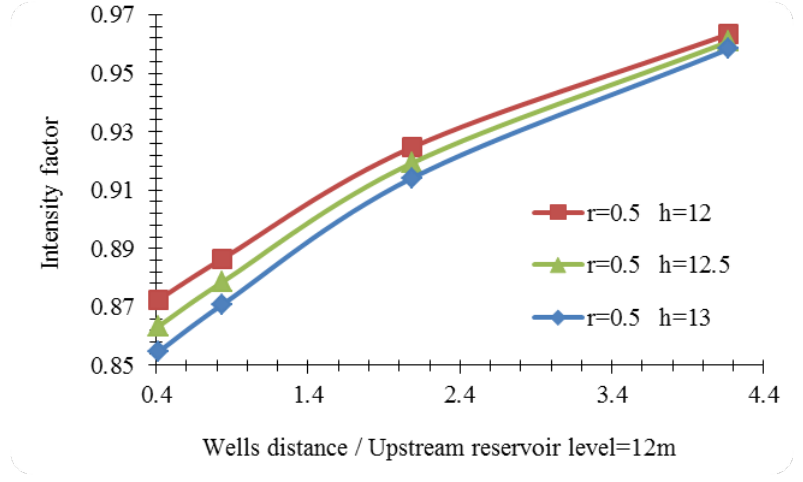
Fig. 12. Effect of upstream reservoir level on uplift pressure for a well with 0.5 m